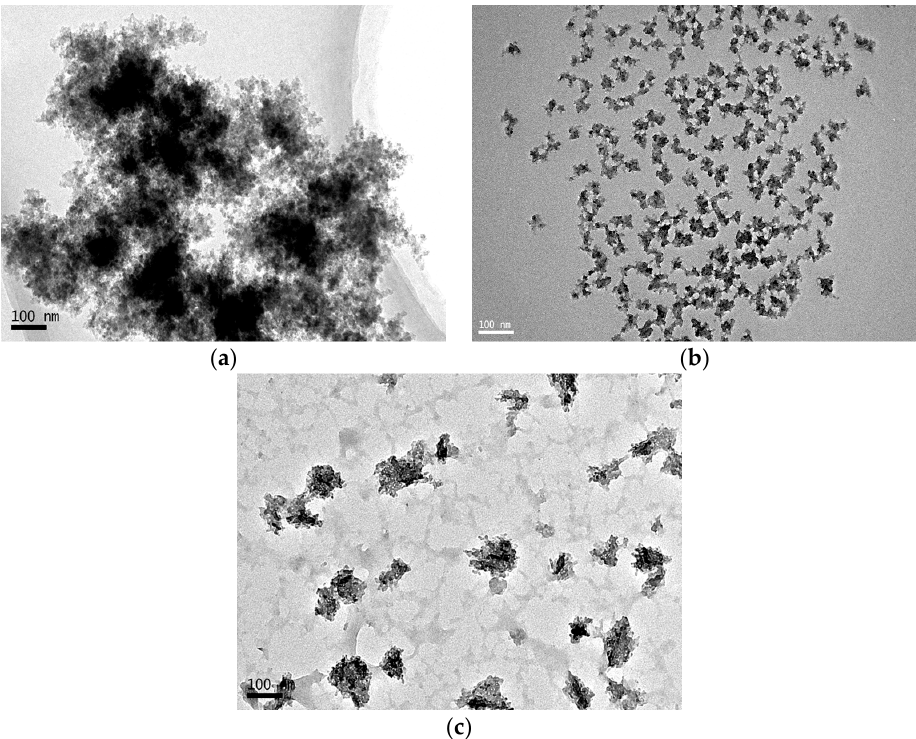
Figure 1. TEM images of ternary nanomaterials. ( a ) More organic alkoxide (with a ratio of 2); ( b ) more alcohol (with a ratio of 75); and ( c ) an appropriate amount of ammonia (with a ratio of 0.1).